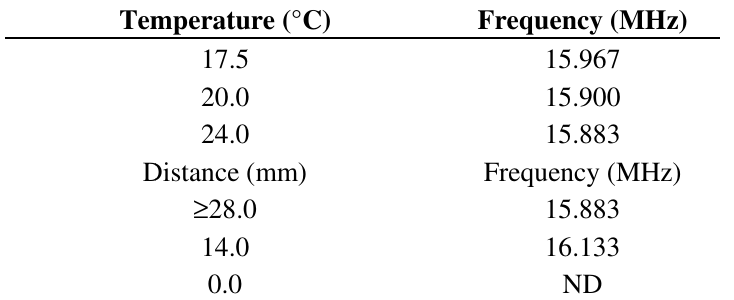
Table 5. Effect of ambient temperature and distance to a steel rebar on the frequency of the